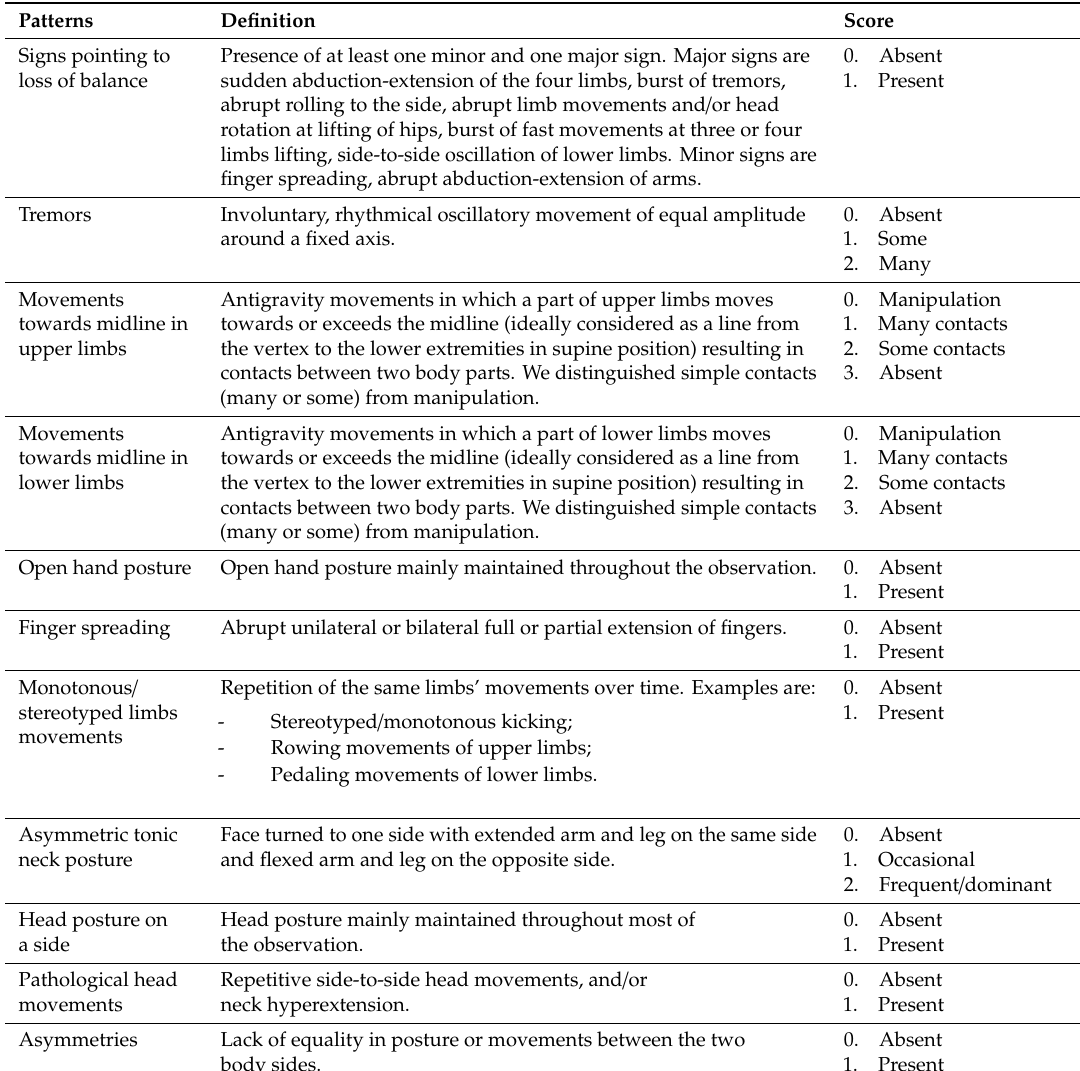
Table 1. Concomitant motor and postural